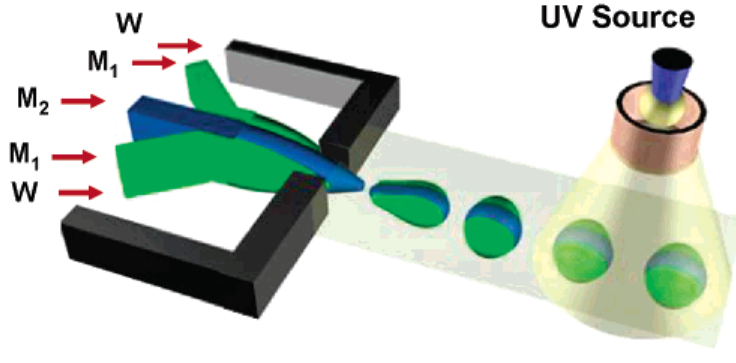
Figure 1. A microfluidic system for the formation of ternary polymer microparticles from immiscible monomers M1 and M2, emulsified in an aqueous solution of sodium dodecylsulfate (W). The droplets are irradiated with UV light in the downstream channel. (Reprinted with permission from [12]. Copyright 2006 American Chemical